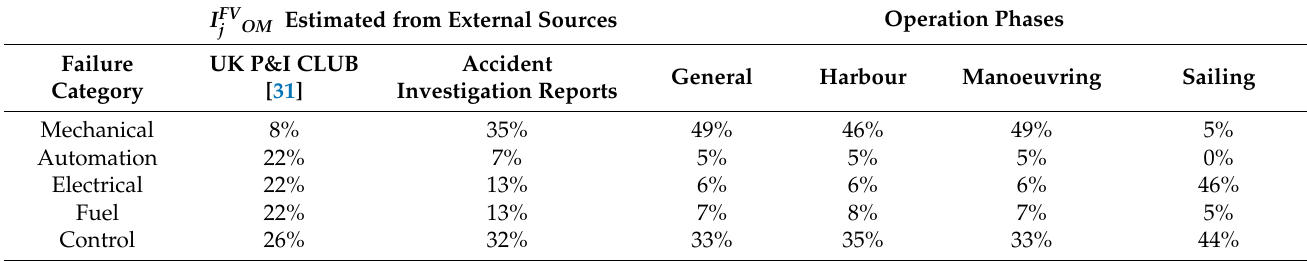
Table 8. Comparison of the calculated results with results from P&I clubs and accident investigation reports for the distribution of causal